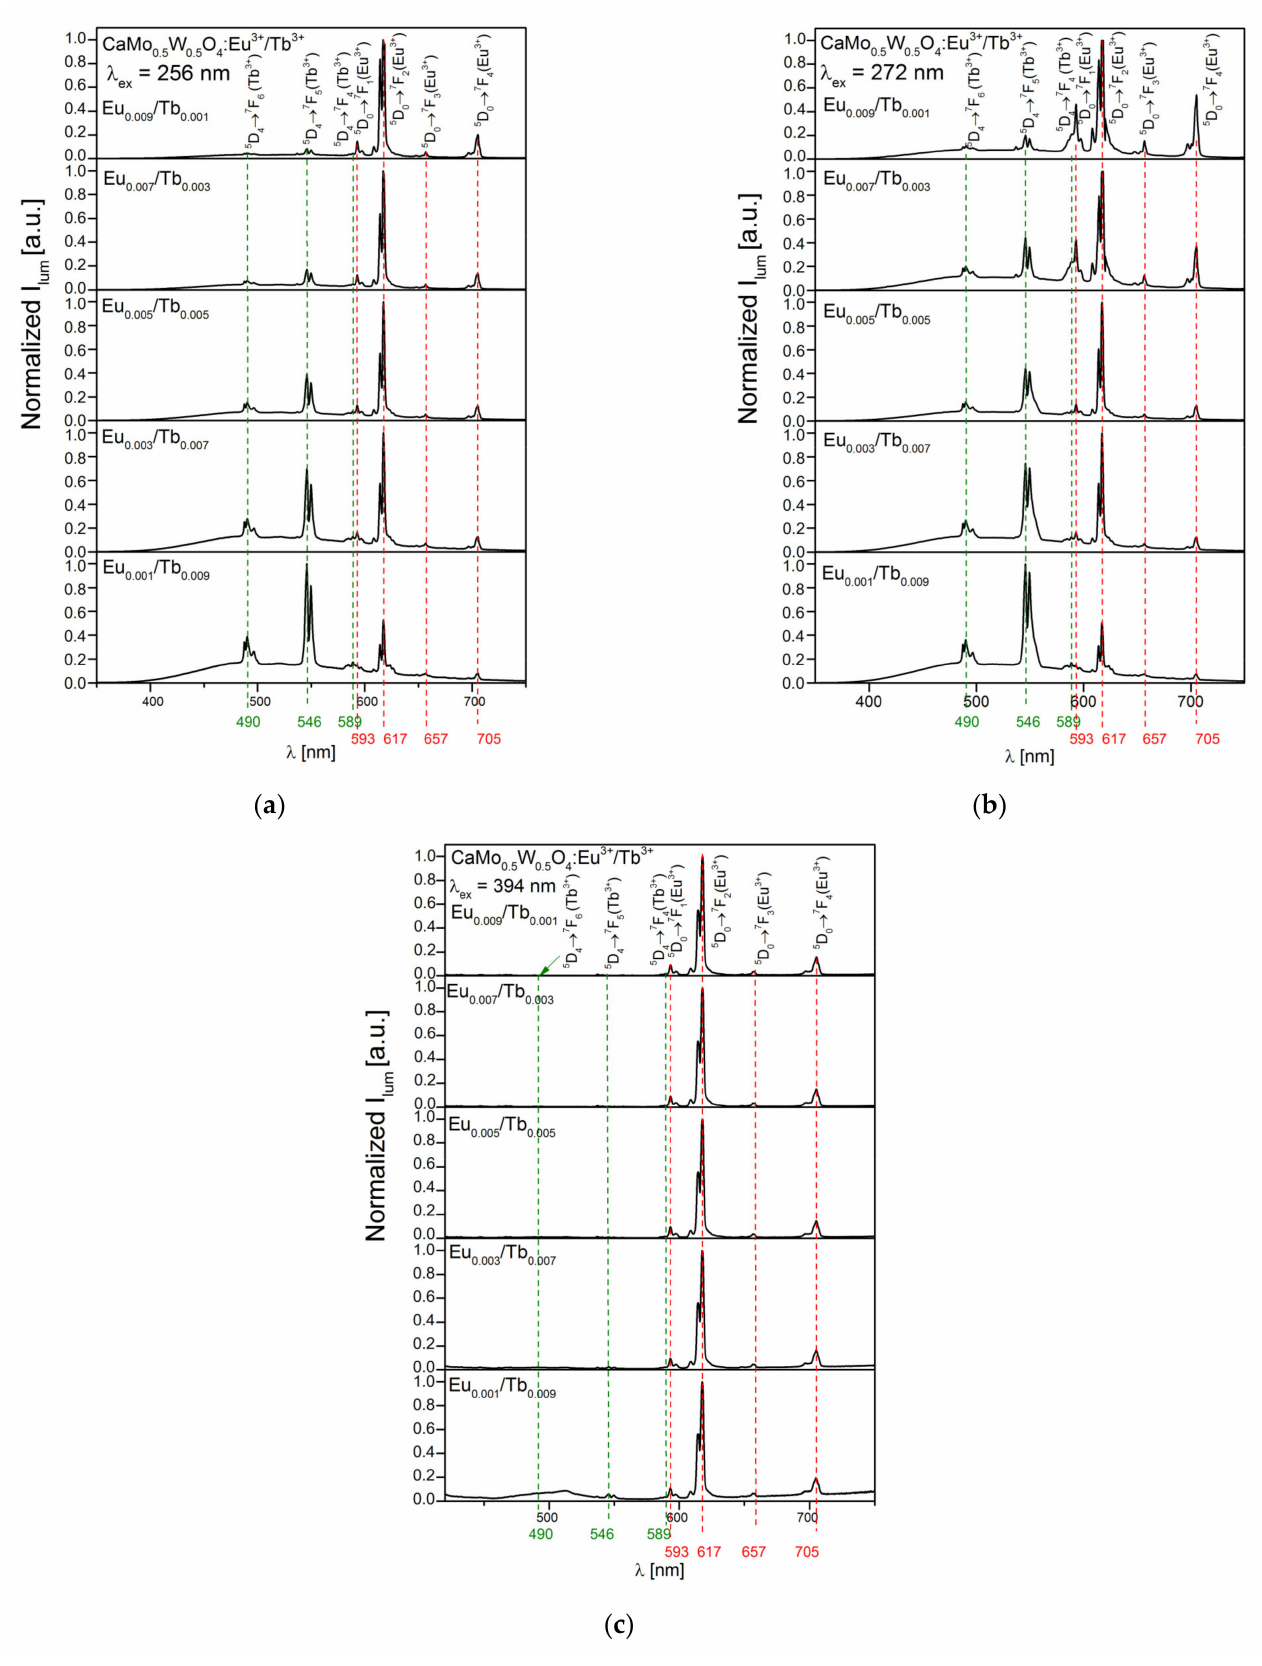
Figure 4. Emission spectra of CaMo 0.5 W 0.5 O 4 :Eu 3+ x /Tb 3+ 1 − x phosphors ( a ) λ ex = 256 nm, ( b ) λ ex = 272 nm, ( c ) λ ex = 394